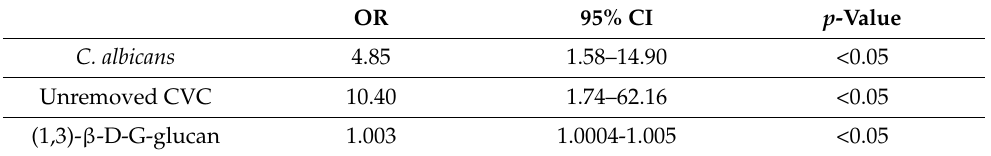
Table 3. Multivariate analysis for the factors with ocular candidiasis in cases with